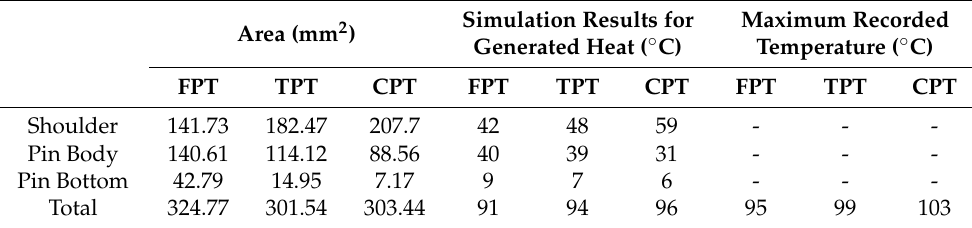
Table 1. Comparison between the area of tools and heat generation